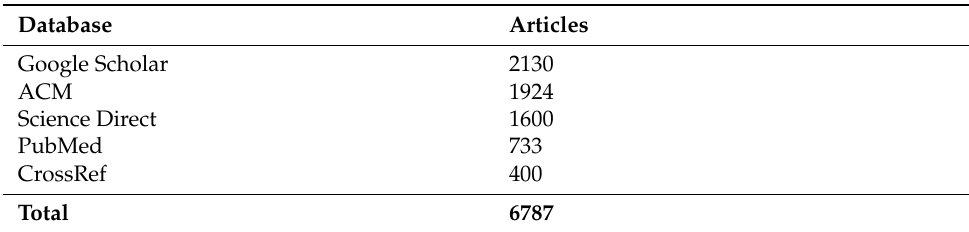
Table 2. Number of articles collected from each